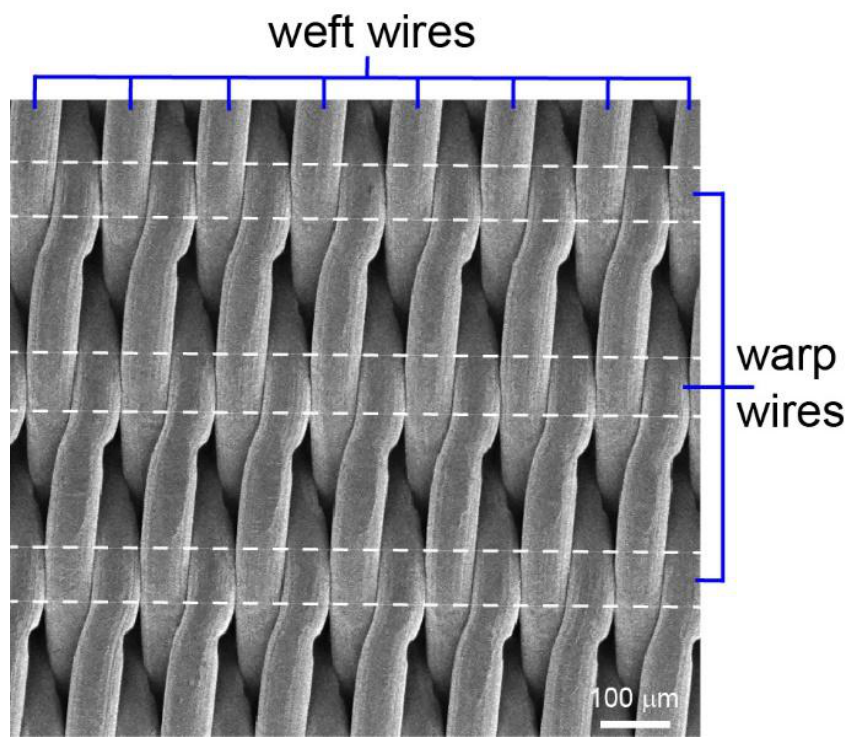
Figure 2. Twill Dutch weave is a densly woven fabric made of 316 stainless steel. It consists of two types of wires: warp (with a higher diameter) and weft (with a smaller diameter). The presented picture is a SEM of 80 × 800 wire mesh.